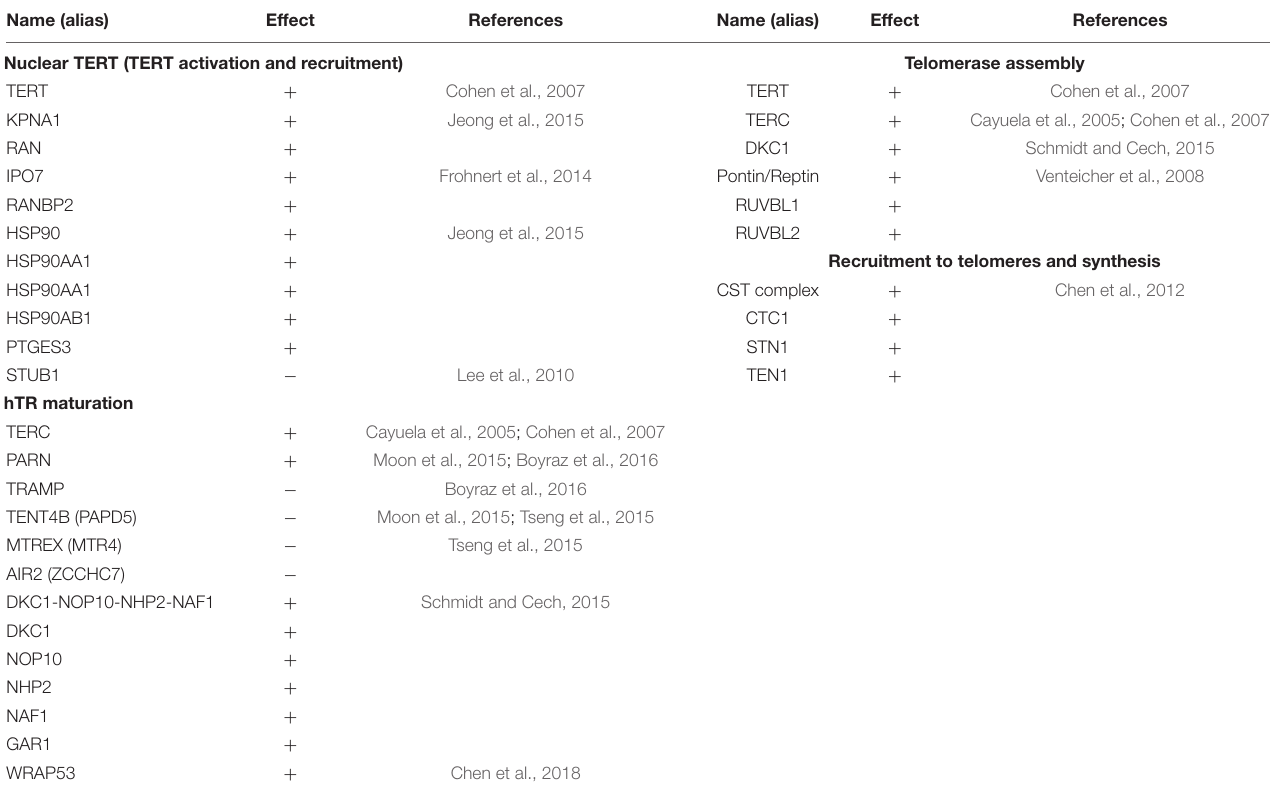
TABLE 2 | The TEL pathway nodes with activating ( + ) or inhibiting ( − )